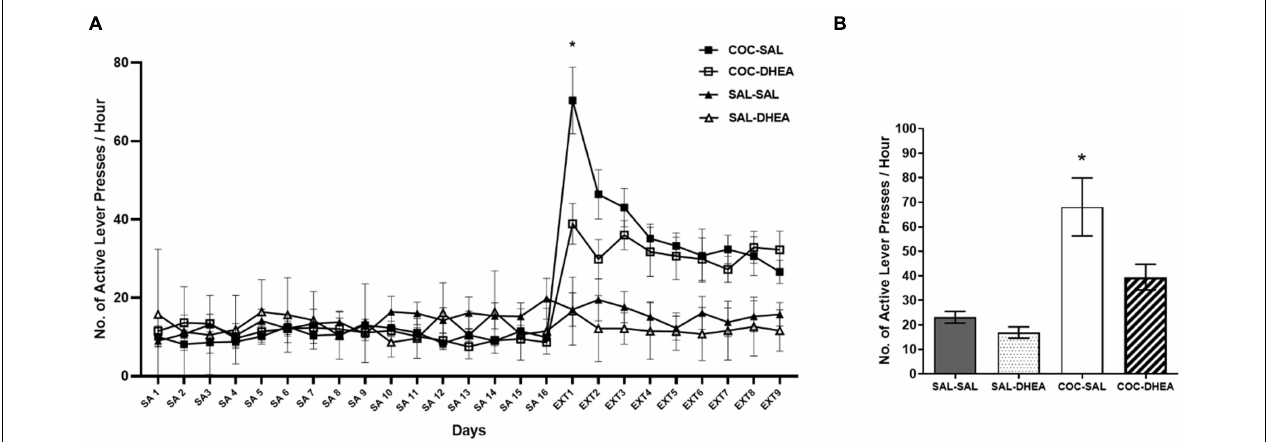
FIGURE 1 | Self-administration and reinstatement test. (A) Effect of DHEA on cocaine-seeking during extinction. Rats ( n = 32) were trained for cocaine self-administration (SA), days 1–16. A three-way ANOVA with repeated measures (drug × treatment × days) revealed a significant three-way interaction [ F (24,627) = 2.057, p < 0.01]. This was followed up by a two-way ANOVA on the data from Ext1, which also revealed a significant interaction [ F (24,260) = 2.024]. A significant number of active lever-presses on the first day of extinction in the COC-SAL group ( n = 8) compared to the COC-DHEA group ( n = 8). SAL-SAL ( n = 8) and SAL-DHEA ( n = 8) groups did not demonstrate any change in active lever presses at Ext 1 ( post hoc *Bonferroni test, p < 0.05). (B) Reinstatement test: number of active lever-presses for 1 h, one month after the end of the extinction phase. COC-SAL and COC-DHEA groups were injected with cocaine (10 mg/kg. i.p.) and put in the operant chambers. The SAL-SAL group received a saline injection. There was a significant effect [ F (3,28) = 11.82, p < 0.0001] of DHEA treatment during drug extinction on drug-seeking behavior in the reinstatement test (*Bonferroni tests, p <